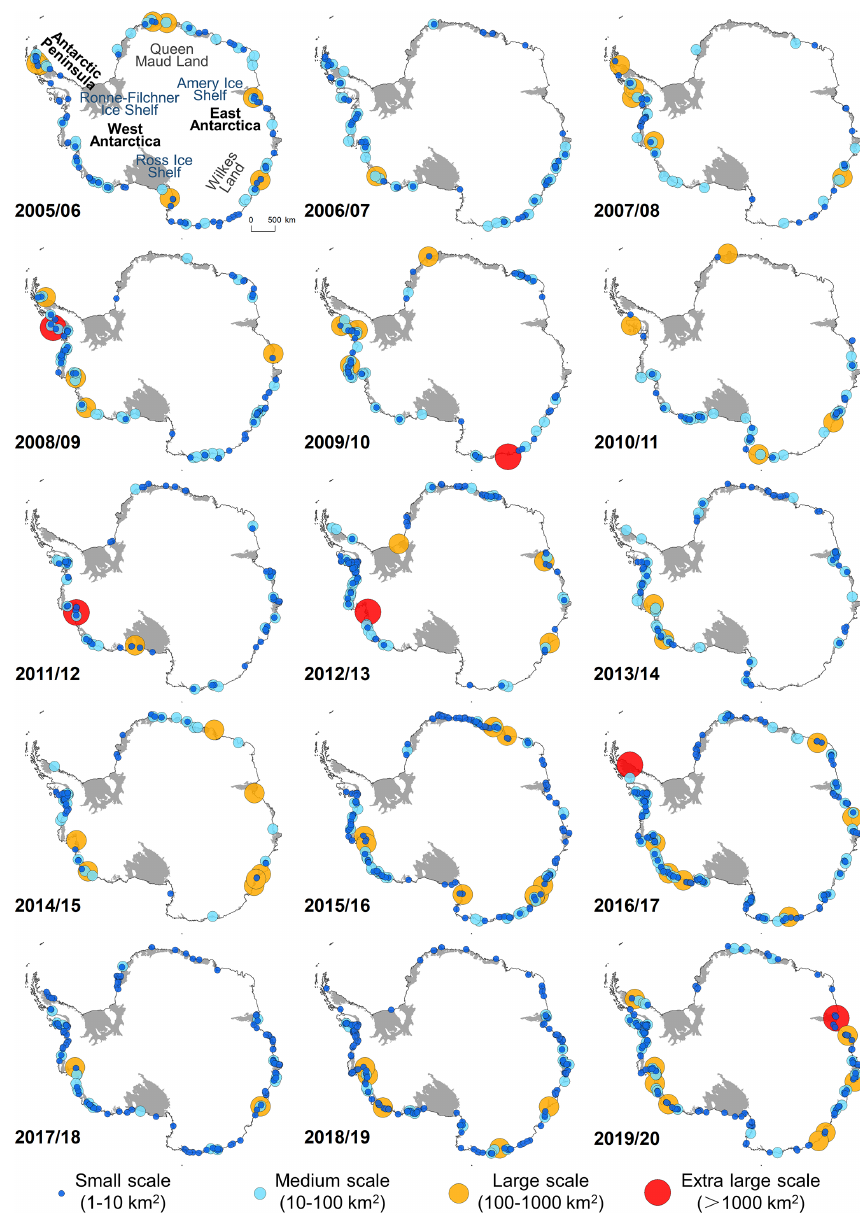
Figure 7. Spatial distribution of annual calving events at different scales from August 2005 to August